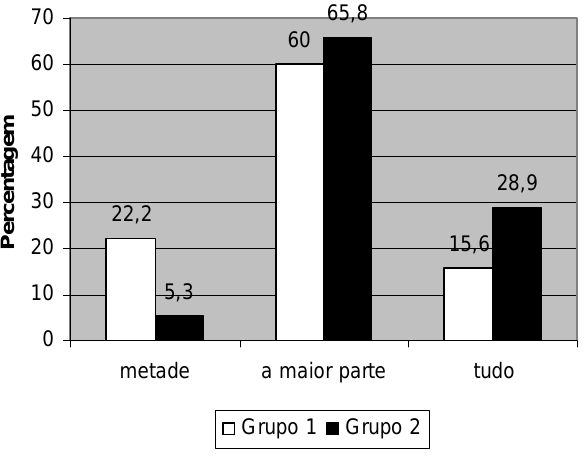
Figura 2. Percentagem da quantidade de conhecimento da informação apresentada nos vídeos por grupo experimental ( N =84).